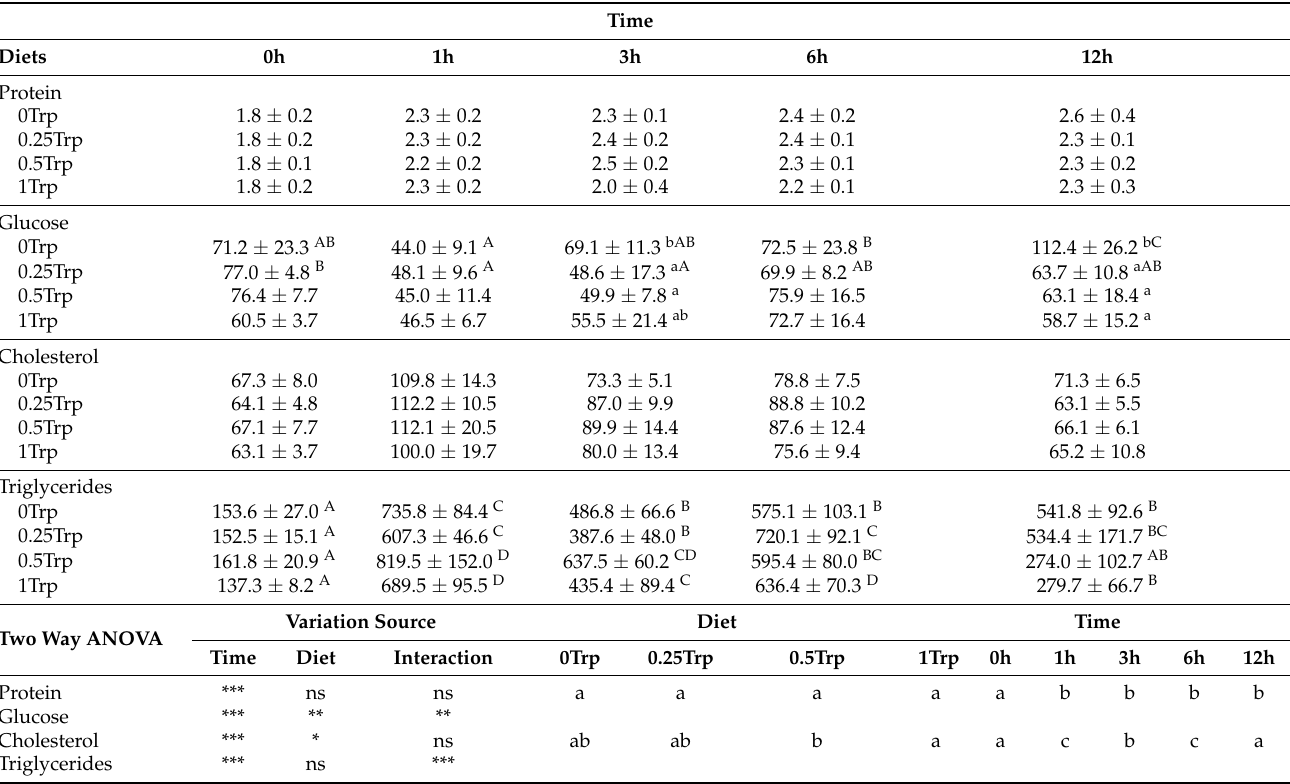
Table 5. Time-course effect of the experimental diets on plasma metabolites concentrations (mg /dL) of